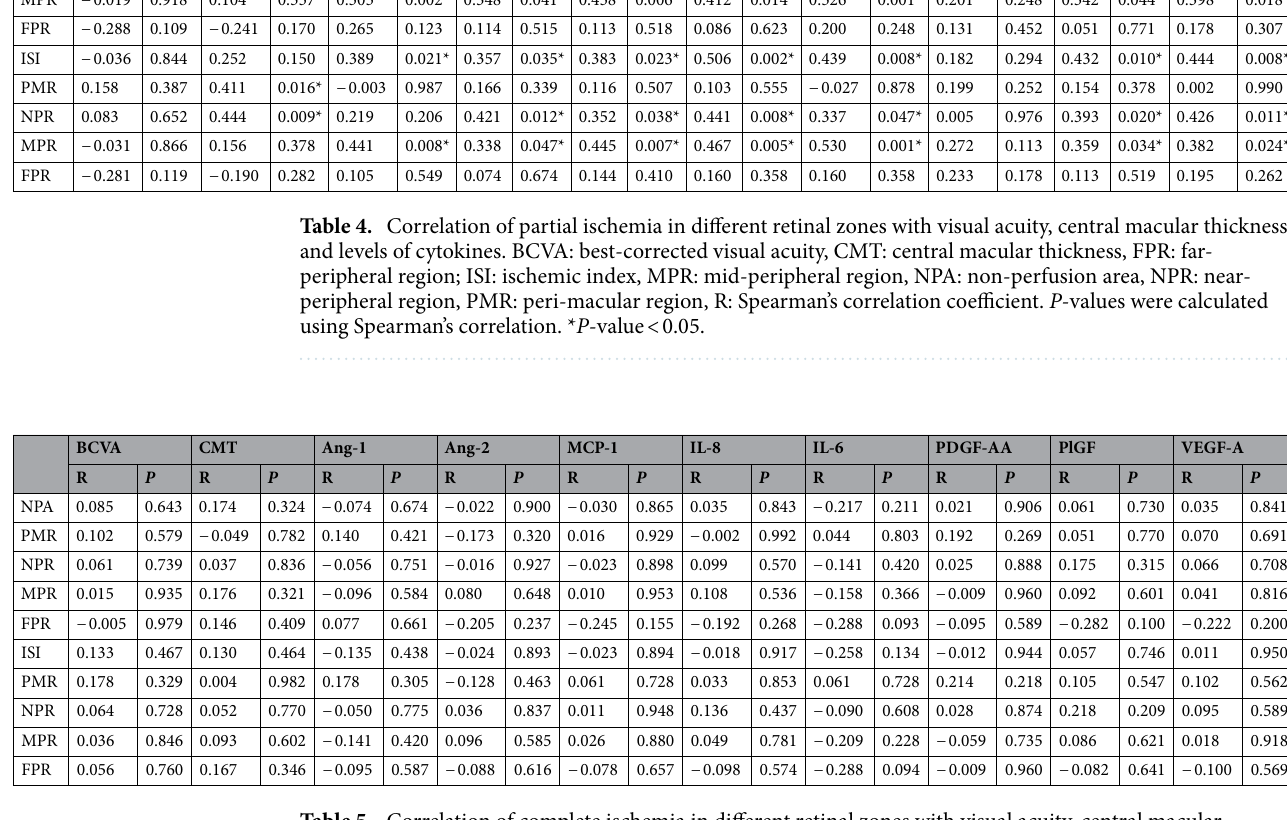
Table 5. Correlation of complete ischemia in different retinal zones with visual acuity, central macular thickness, and levels of cytokines. BCVA: best-corrected visual acuity, CMT: central macular thickness, FPR: far-peripheral region; ISI: ischemic index, MPR: mid-peripheral region, NPA: non-perfusion area, NPR: near- peripheral region, PMR: peri-macular region, R: Spearman’s correlation coefficient. P -values were calculated using Spearman’s correlation. * P -value <